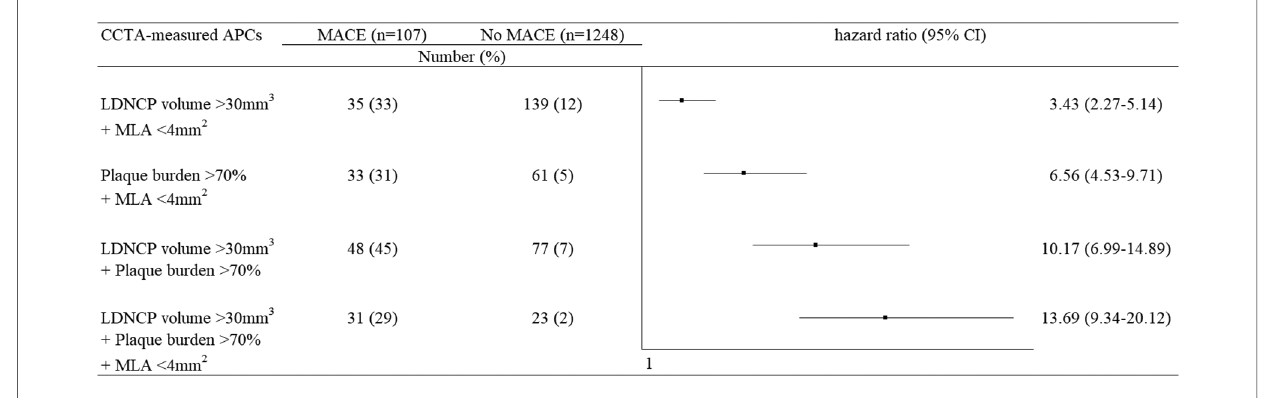
FIGURE 4 Association between the study endpoints and different combinations of APCs of NCL.